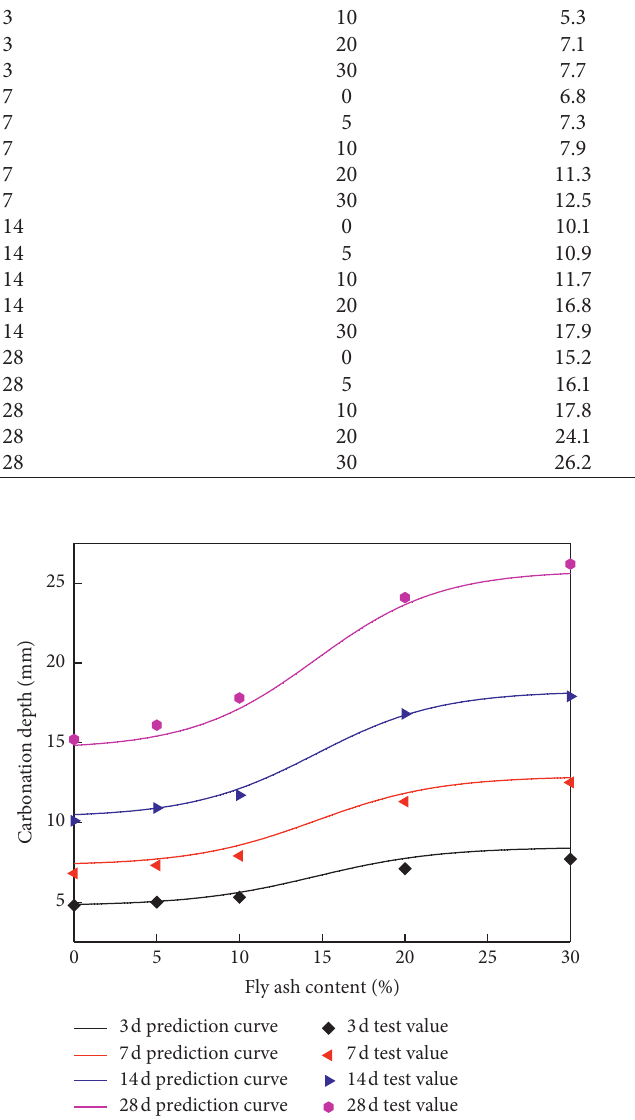
Figure 10: Predicted and experimental values of carbonation depth of hybrid fiber fly ash concrete.